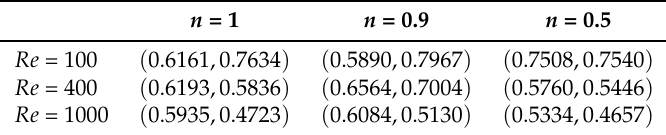
Table 1. Location, ( x , y ) , of the primary vortex